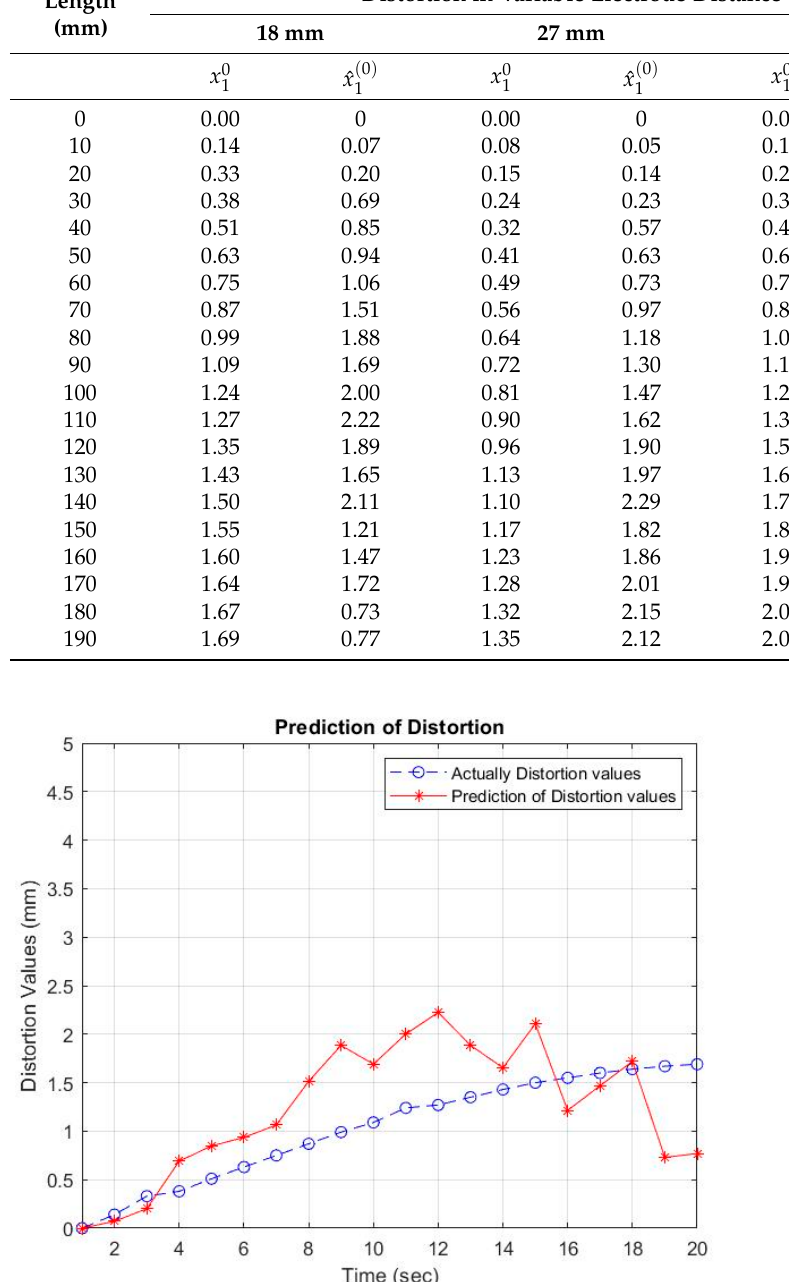
Table 5. Welding distortion for different electrode distances.